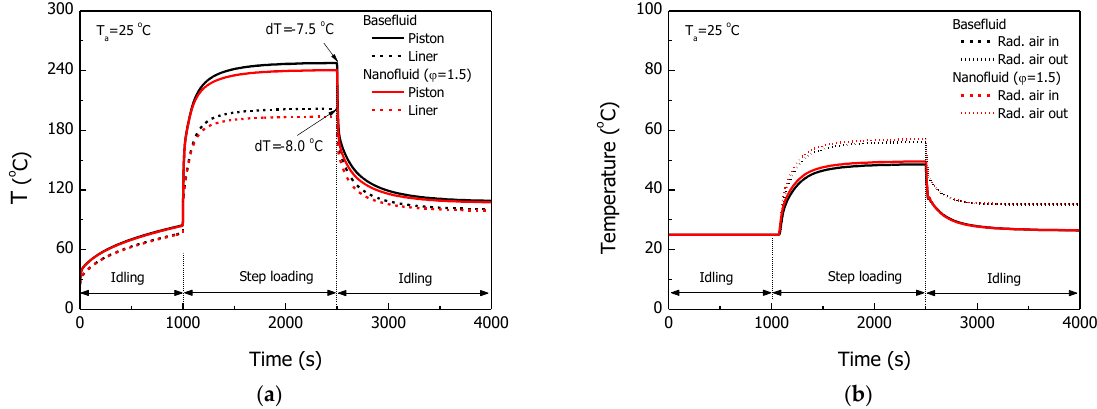
Figure 11. Temperature results for the diesel engine with Al 2 O 3 nanofluids at 216 Nm step-load and 2050 rpm engine speed: ( a ) piston and liner; ( b ) engine and radiator.